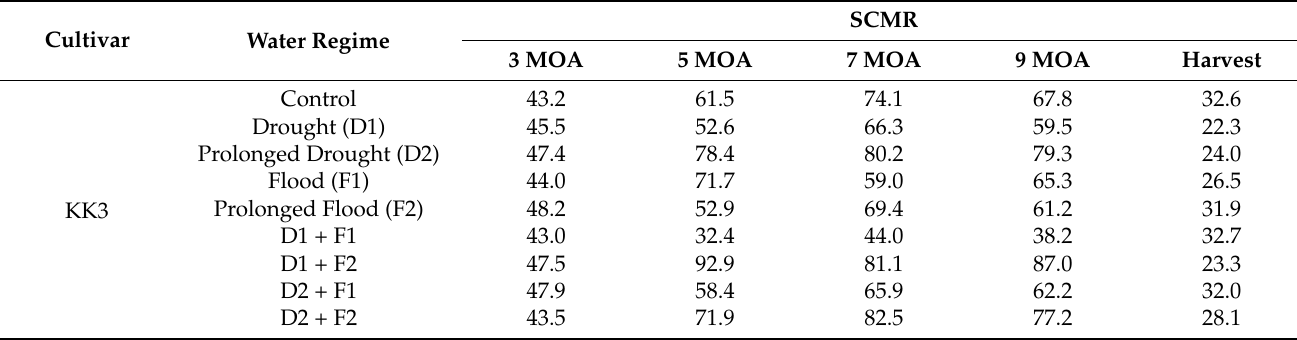
Table 2. SPAD chlorophyll meter reading (SCMR) of two sugarcane cultivars at 3, 5, 7, 9 months of age, and at harvest as affected by drought, flood, and combined treatment, Experiment 1.